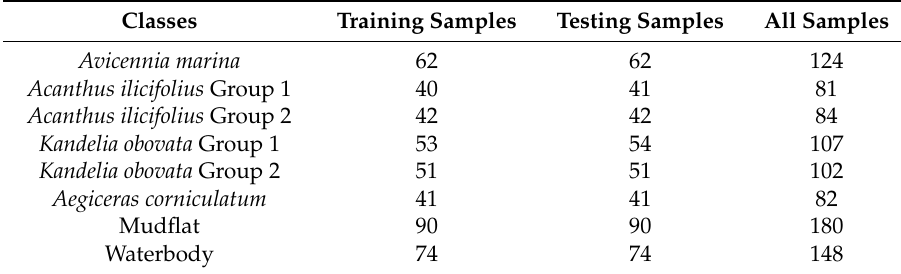
Table 1. Sample points for training and accuracy